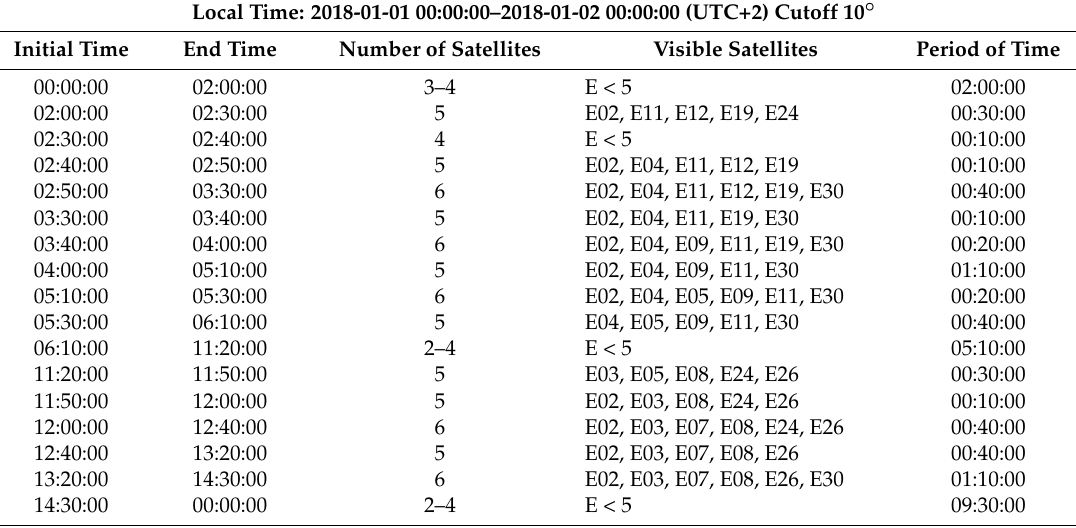
Table 5. Galileo satellites availability for the Day of Year: 001,